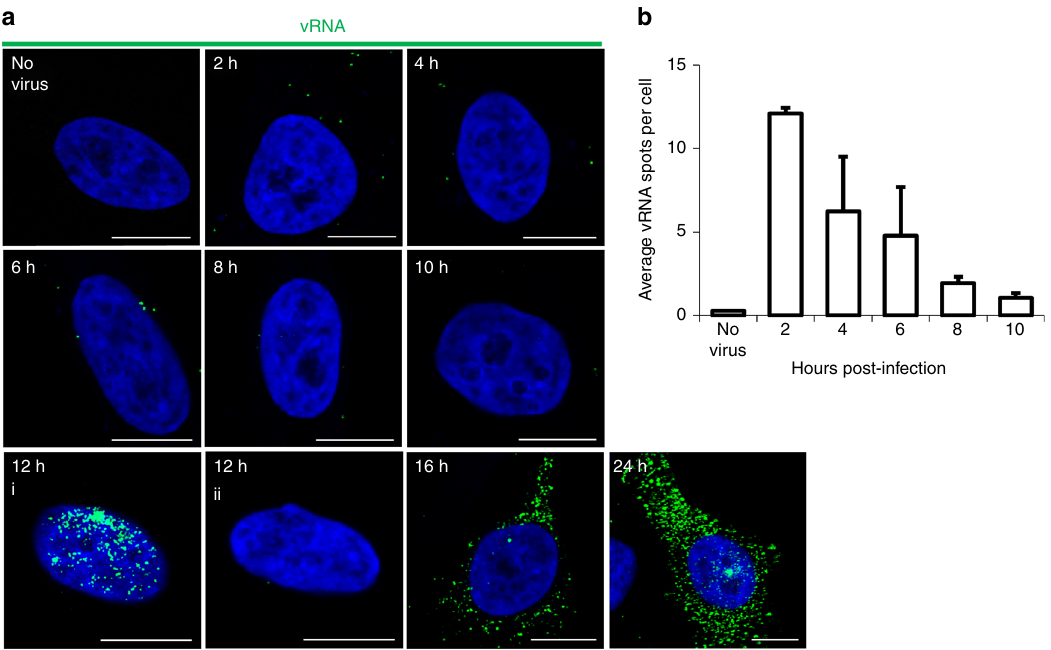
Fig. 2 Time course of vRNA detection. a TZM-bl cells were infected with HIV-1 at an MOI of 0.2. Cells were then fi xed and stained at the indicated times. Cells were stained for vRNA (PS-1; green) and nuclei (blue). At 12 hpi, ~15% of infected cells exhibited a transcription burst (12 h, i) whereas most cells did not yet produce nascent vRNA (12 h, ii). Scale bars represent 10 µ m. b Foci of vRNA were counted in 300 – 340 cells per time point, using Gen5 software. The average number vRNA foci per cell was calculated and shown in the graph with standard deviation indicated ( n = 2 independent